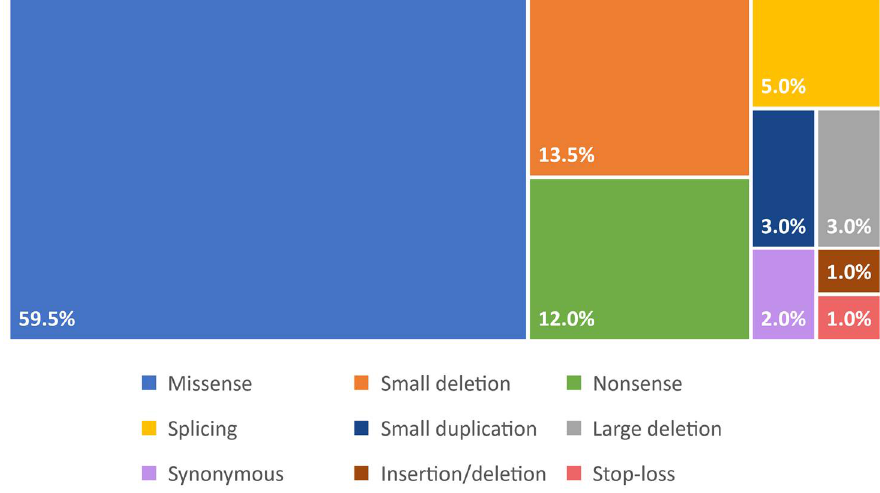
Figure 2. Distribution of variant types in the ARSB gene. Data from [17] with